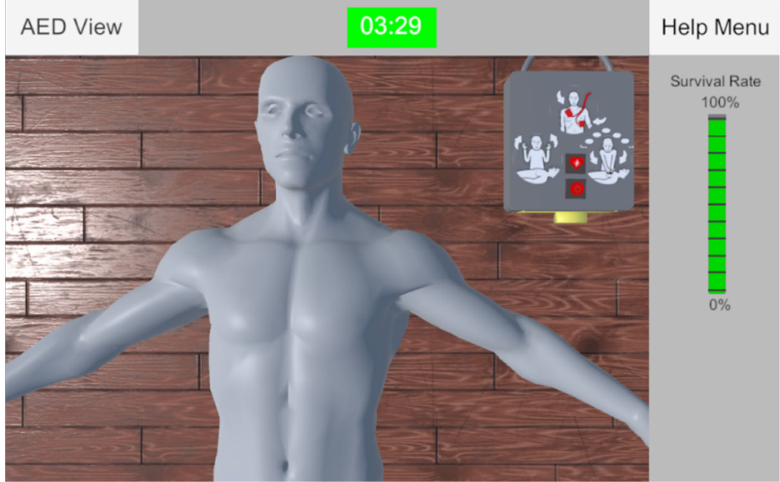
Figure 9. Updated starting view of the AED